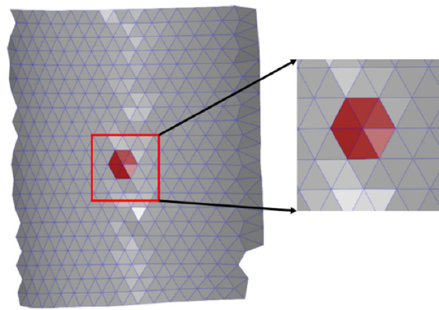
Figure 9. Calculation of the strain rate of the lead block using node element.